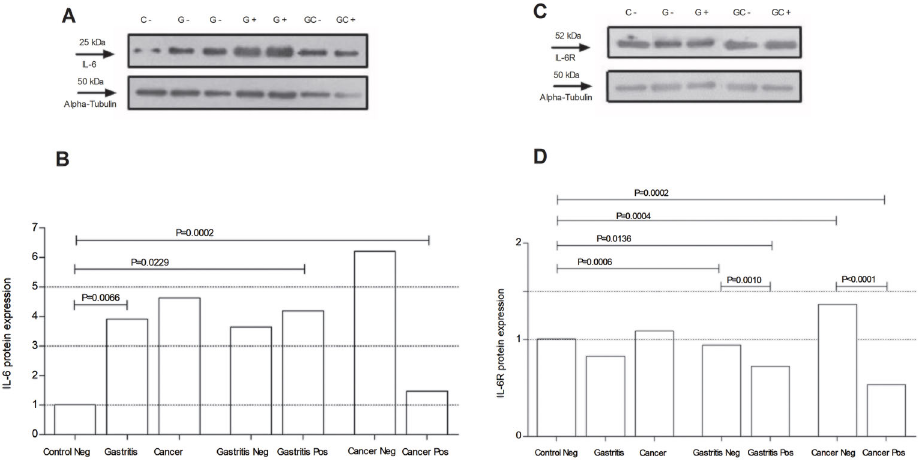
Figure 5. A , Levels of interleukin (IL)-6 were examined in samples from patients with Gastritis (G) and Gastric Cancer (GC) and from Control (C) by western blot analysis. B , Analysis of IL-6 protein expression in groups, considering or not the presence of H. pylori . C and D , Levels of IL-6 receptor (IL-6R) in the same samples. Data are reported as medians and interquartile range (Student ’ s t -test). neg and pos: negative and positive for H. pylori